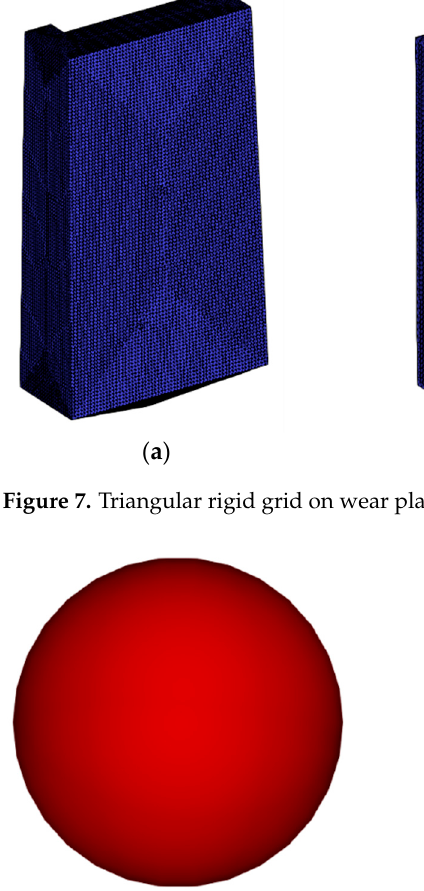
Figure 8. Assumed spherical shape for soil particles.